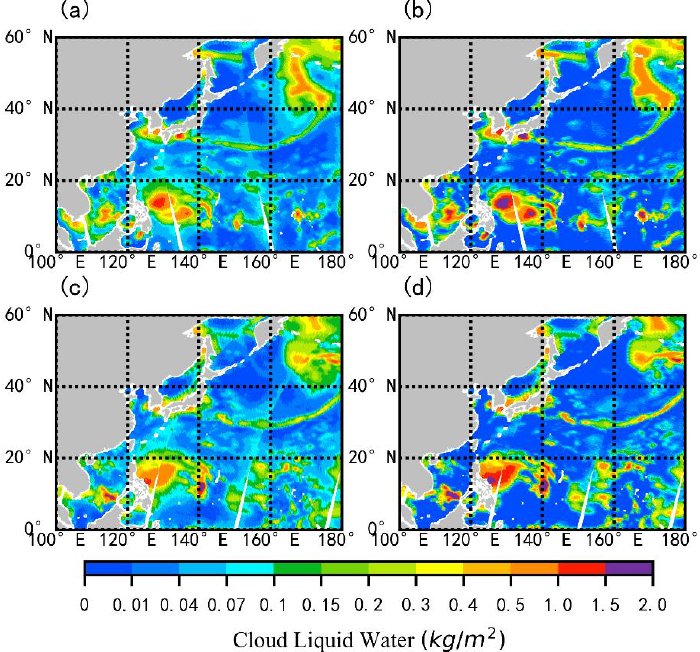
Figure 9. CLW in the northwest Pacific on 13 September 2018 retrieved from ATMS by using the ( a ) statistical algorithm and ( b ) the physical algorithms at the ascending orbit; ( c , d ) those from the descending orbit.